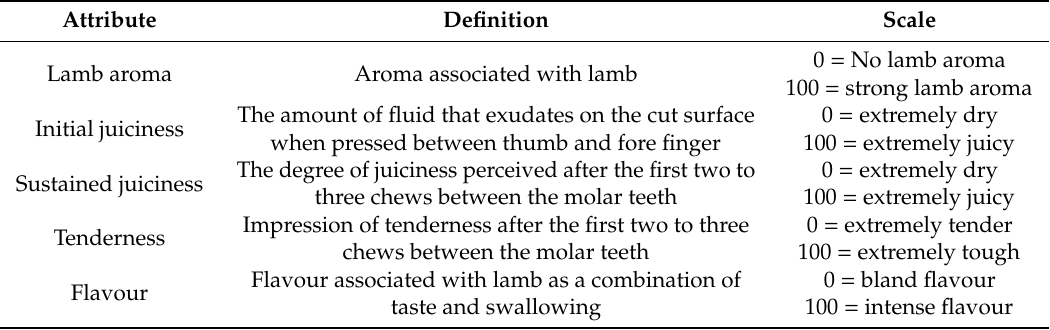
0 = No lamb aroma 100 = strong lamb aroma 0 = extremely dry 100 = extremely juicy 0 = extremely dry